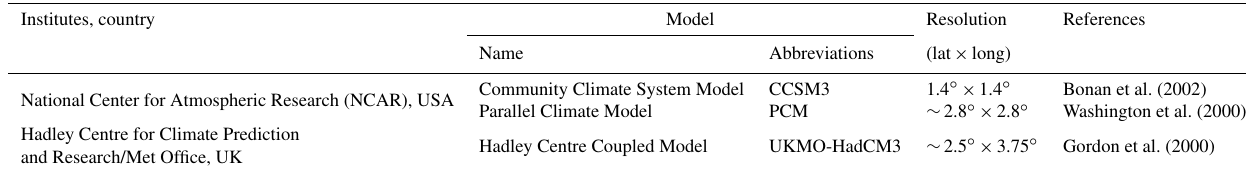
Table 3. List of the GCMs participating in CMIP3 used in this study with their approximate atmospheric horizontal resolution. Institutes,